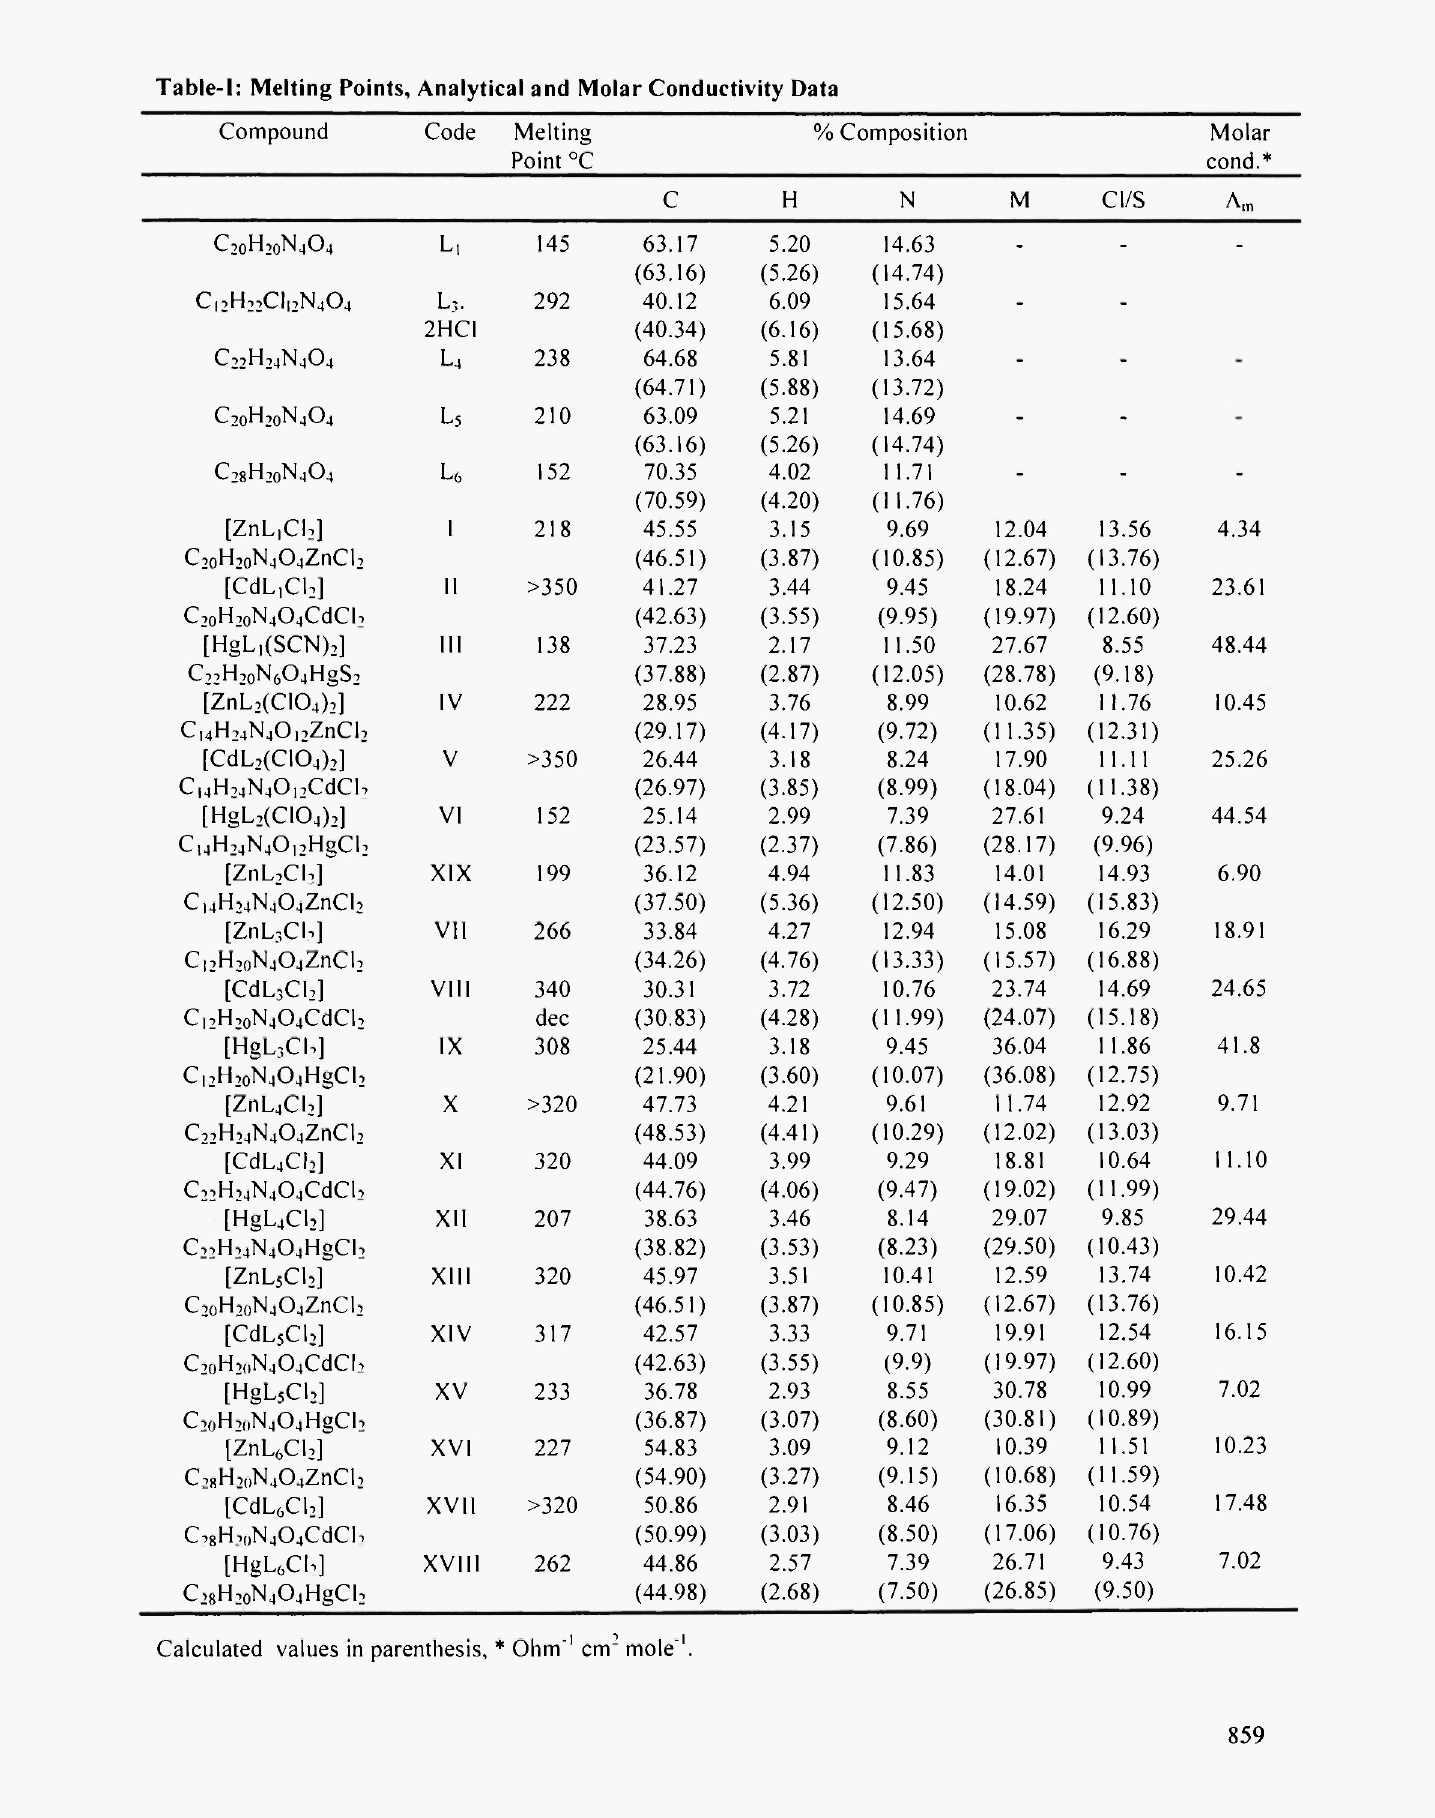
Table-1: Melting Points, Analytical and Molar Conductivity Data